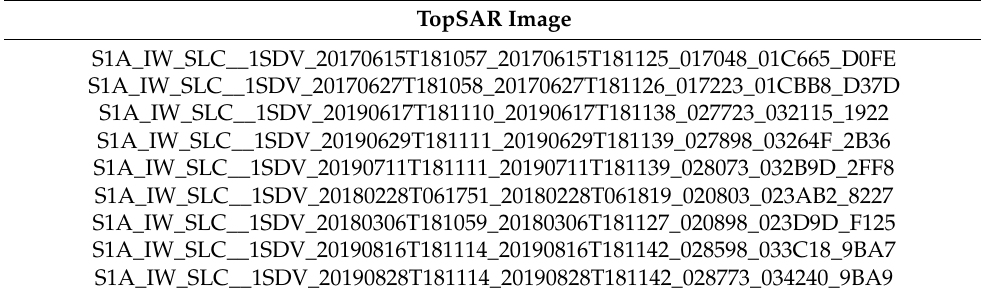
Table 1. The ascending orbit S-1A satellite TopSAR images used in the present work.